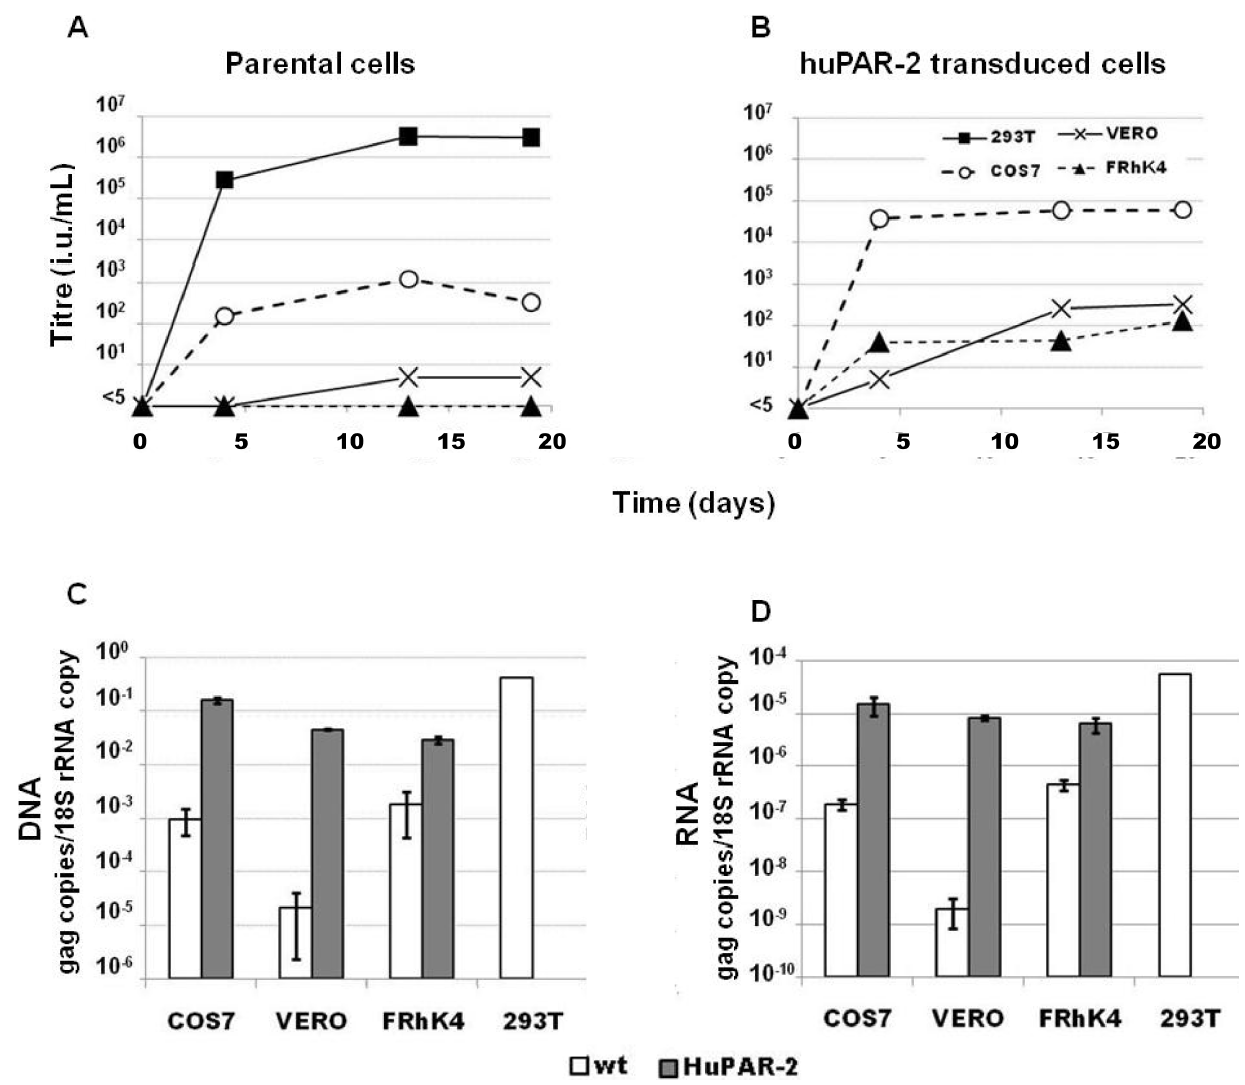
Figure 1. PERV-A infection analysis in NHP cell lines. HuPAR-2 gene was delivered into rhesus macaque FRhK4 cells, AGM COS7 and VERO cells using a VSV-G pseudotyped MLV-based vector. HuPAR-2 transduced or wild type NHP cells and human 293T cells were infected with PERV-A14/220 at MOI 20 (titer calculated on 293T cells). A and B ) At the different time points indicated, 1 6 10 6 PERV-infected cells FRhK4 (black triangle), COS7 (white circle), VERO (cross) and 293T (black square) cells were seeded. The day after, supernatant was collected and 5-fold dilutions used to infect 293T cells. 72 hrs later, cells were immunostained with an anti-PERV CA antibody. Data represent the average of two independent experiments ( 6 standard error of the mean, SEM). C ) One week post-infection, genomic DNA was extracted and copy numbers of PERV gag and 18S rRNA gene were measured by quantitative PCR. D ) Two weeks post-infection, total RNA was extracted and RNA copy numbers of PERV gag and 18S ribosomal RNA were measured by quantitative RT-PCR. PERV gag copy number was calculated from standard curves and normalised per 18S rRNA copy. Each sample was run in duplicate. Histograms represent the average of two independent experiments ( 6 SEM).